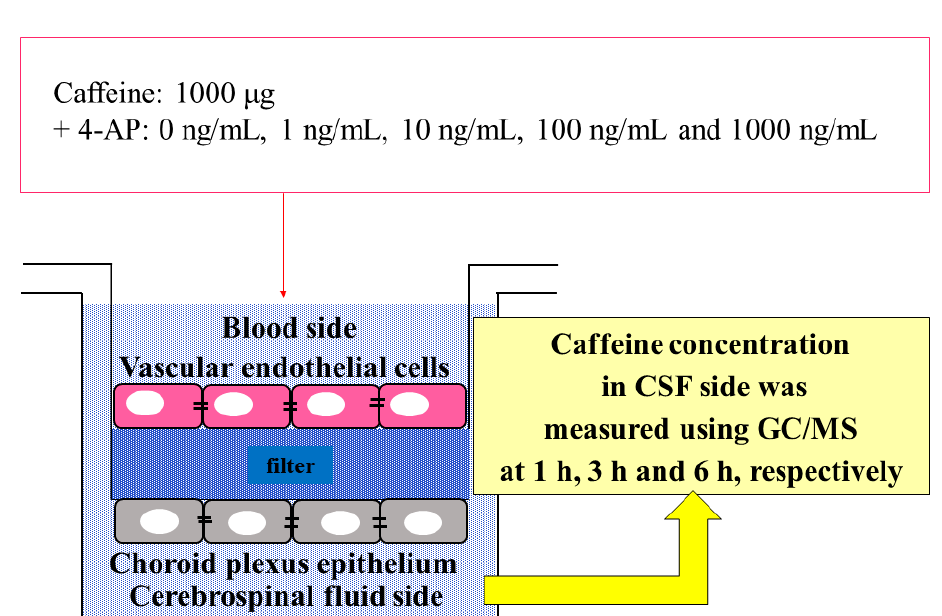
Figure 8. Caffeine and 4-AP administered in the BCSFB model. Caffeine concentration in CSF side was measured using GC/MS at 1, 3 and 6 h, respectively.